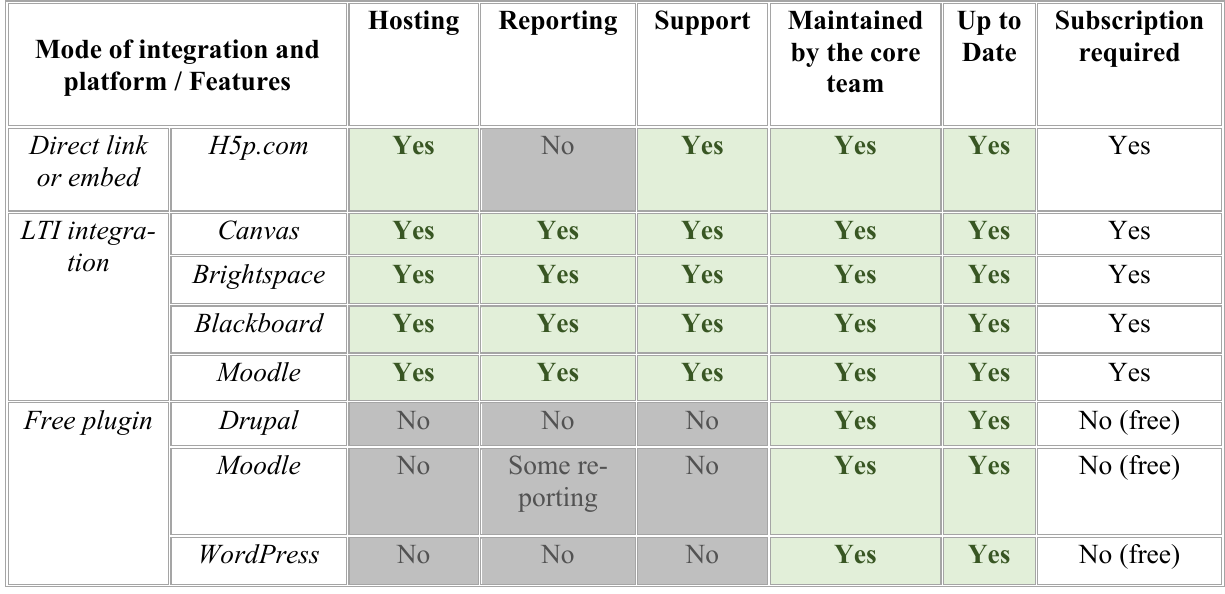
Table 1 Integrations and features for H5P